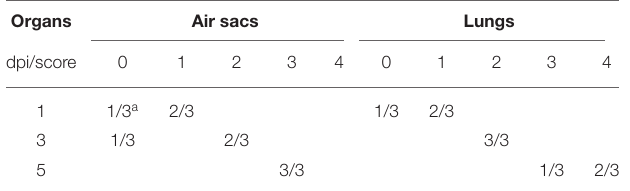
TABLE 3 | Histopathological lesions scoring of the right infected